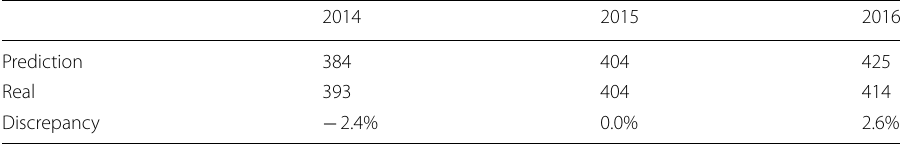
Table 5 Predicted urban employment (million people). Source: author’s